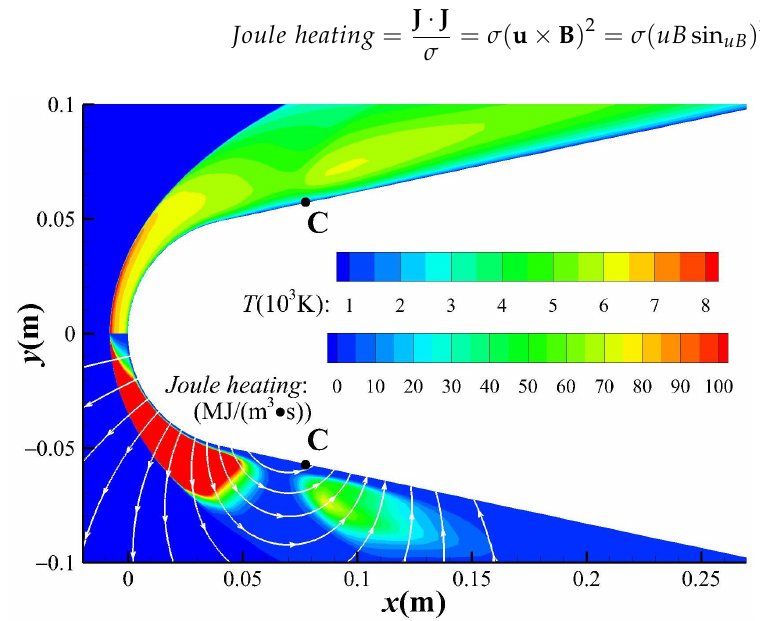
Figure 18. Distribution of temperature and Joule heating of case